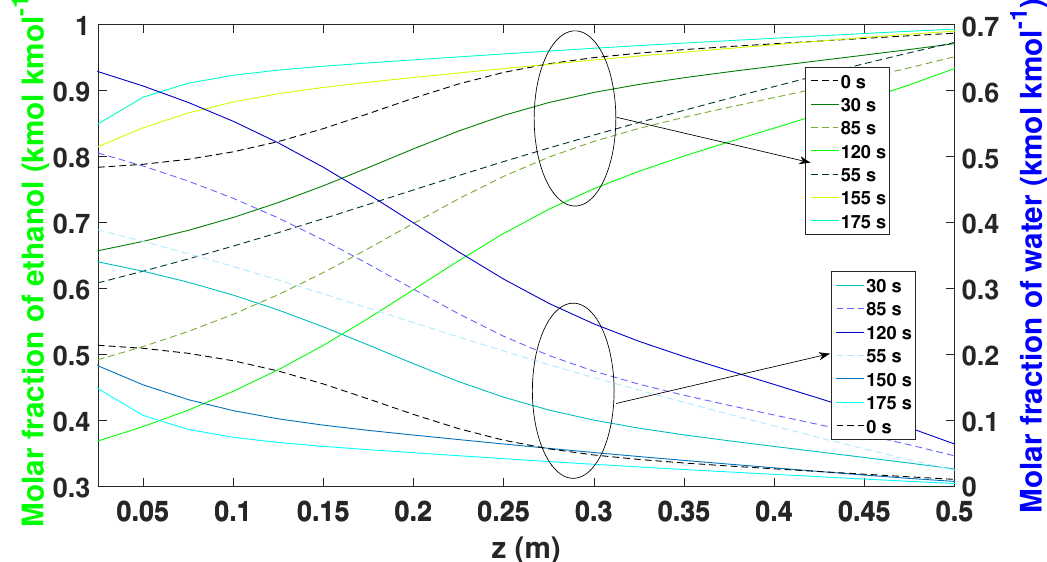
Figure 14. Molar fraction of ethanol–water during the regeneration phase while in the CSS. For the case of the temperature profiles in the adsorption and regeneration stages, it is observed that there is a decrease in temperature along the column (Figure 15) because part of the 12 and 20 nodes (discretized length) did not generate good adsorption at these distances. Thus, it is important to control and keep the temperature constant.